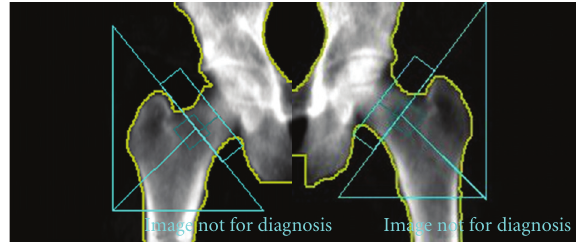
Figure 1: Left and right hip dual energy X-ray absorptiometry scans showing regions of interest used for analysis.